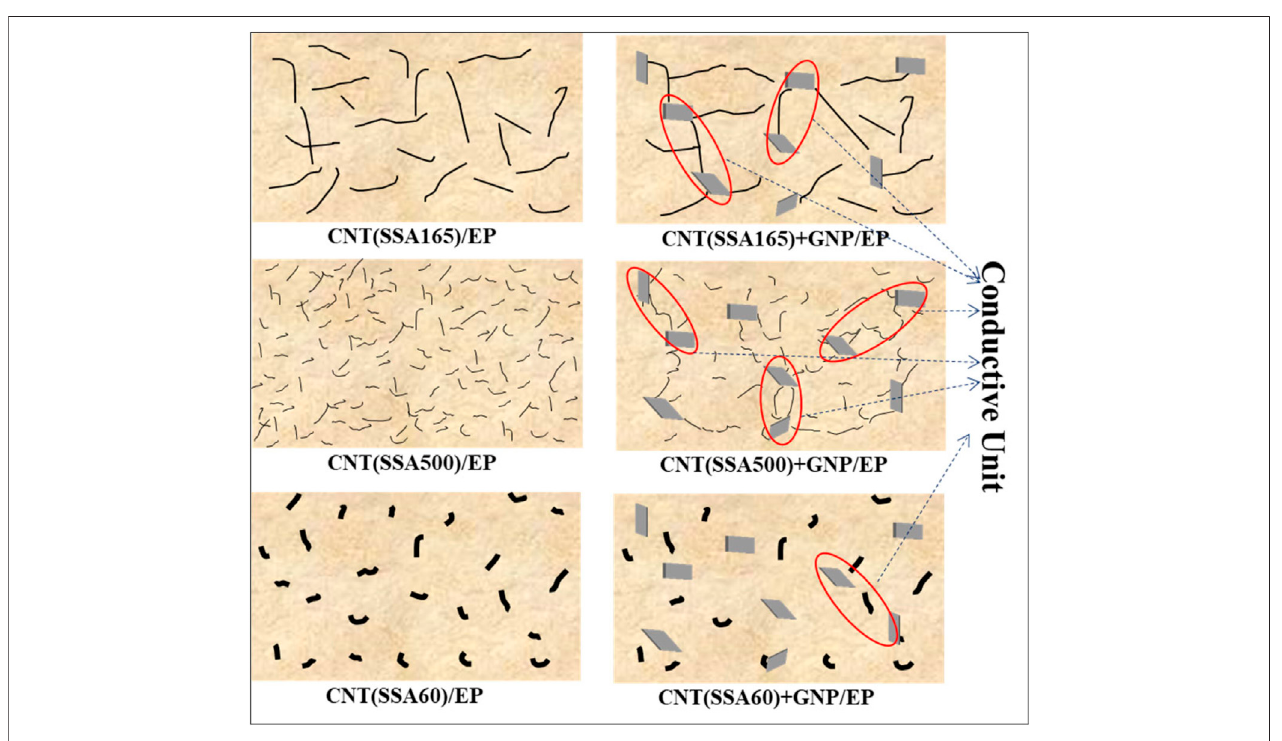
FIGURE 8 | Schematic diagram of conducting network structure.